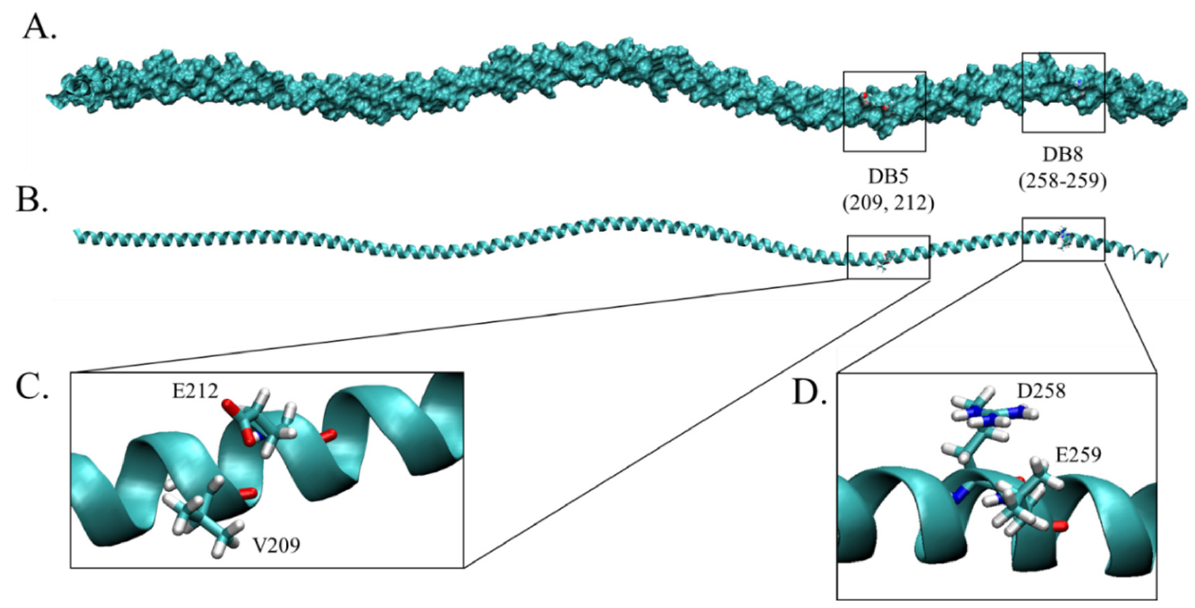
Figure 4. Cross-reactive epitopes identified by the linear B cell, linear T cell, and discontinuous B cell epitope analysis. ( A ) The structure of black tiger shrimp illustrated as surf conformation. The possible cross-reactive epitopes with high affinity to T cell MHC molecules were indicated in the square. ( B ) The new cartoon structure of tropomyosin with the predicted cross-reactive epitopes. ( C ) The identified epitope residues glutamic acid (E) and valine (V) at positions 212 and 209, respec- tively, in DB5 epitope. ( D ) The continuous amino acids aspartic acid (D258) and glutamic acid (E259) were illustrated as part of epitope